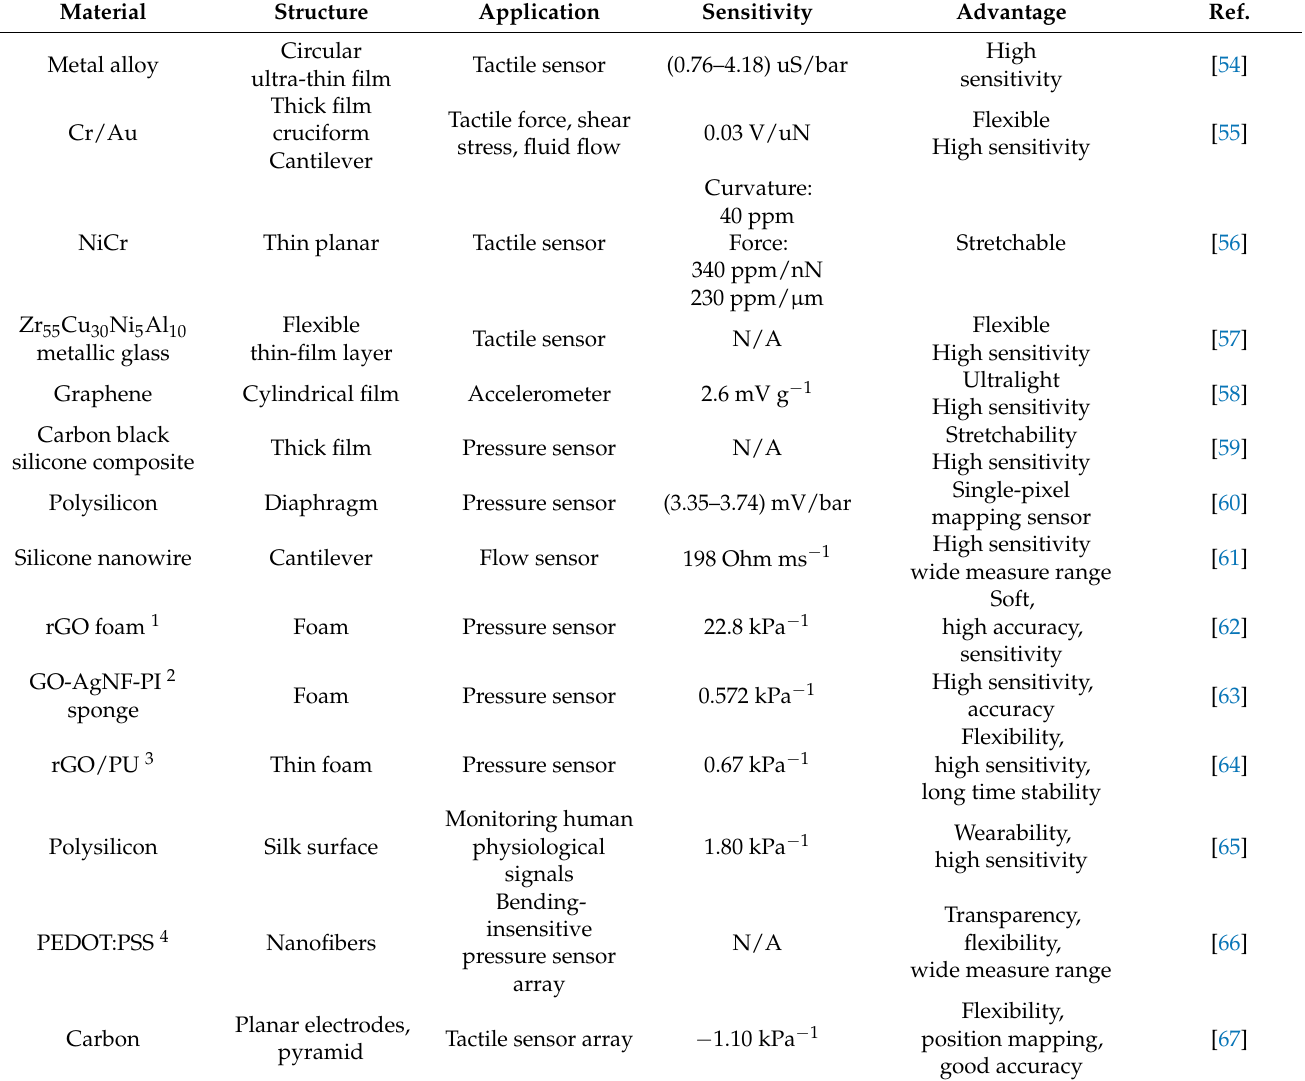
Table 1. Comparative sensing performances of the piezoresistive-based